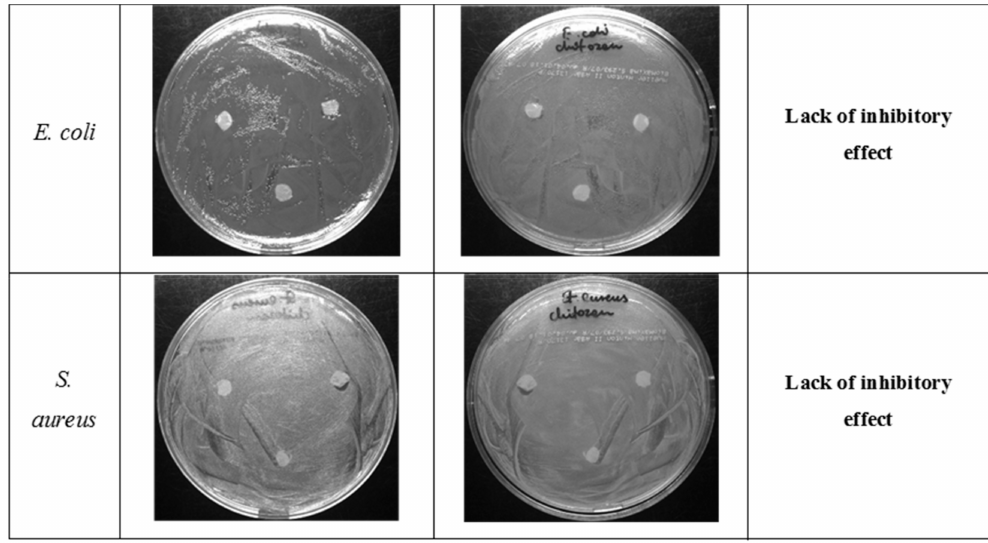
Figure 9. Photographs of the growth of E. coli ATCC 25922 and S. aureus ATCC 25923 on MH agar plates with placed discs cut from CS / silica